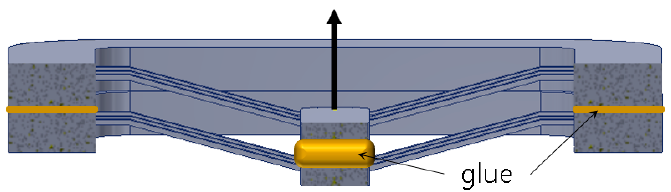
Figure 13. Double V-beam structure made by stacking up two molded single V-beam parts.